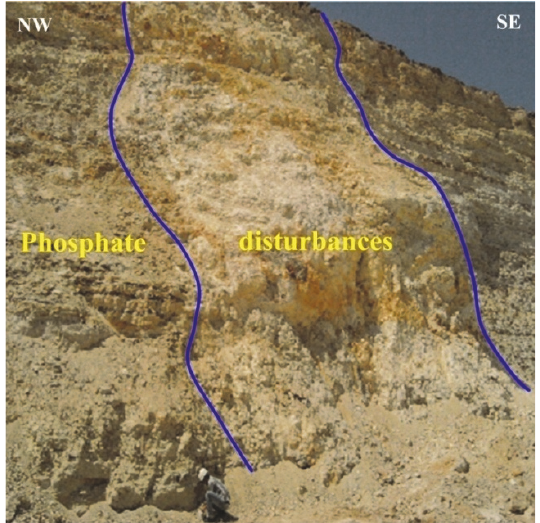
Figure 2: Geological sections showing disturbed phosphate series fronts in Sidi Chennane